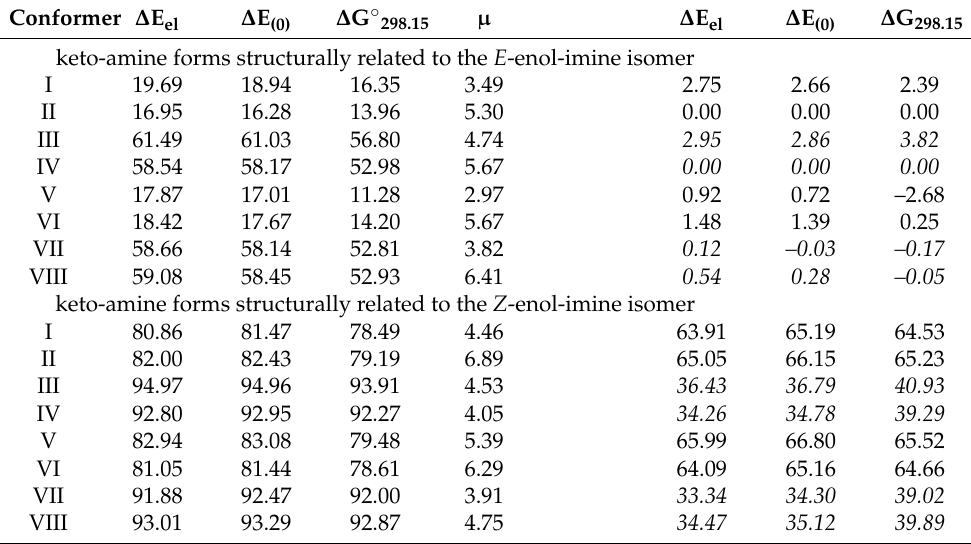
Table 4. B3LYP/6-311++G(d,p) calculated relative electronic energies ( ∆ E el ), zero-point corrected relative energies ( ∆ E (0) ), standard Gibbs energies at 298.15 K ( ∆ G ◦ 298.15 ), and dipole moments ( µ ) for the keto-amine conformers of BHAP